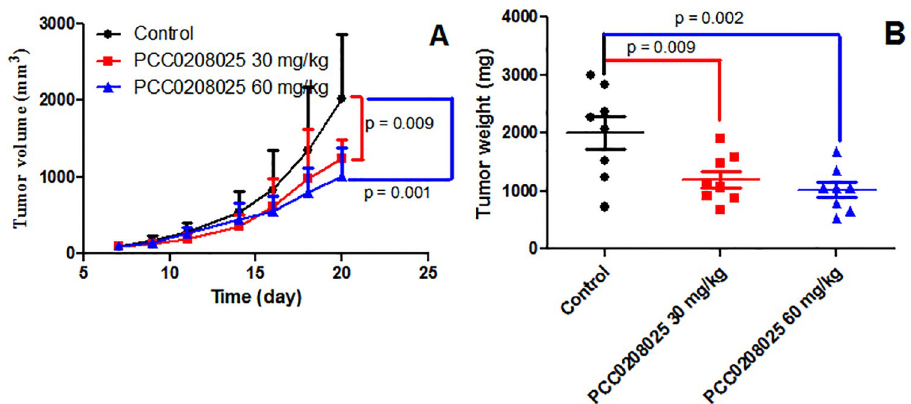
Fig 4. Effects of PCC0208025 on tumor growth in B16-F10 tumor isograft model. B16-F10 tumors were established by injecting 1 × 10 5 cells mixed with matrigel into the dorsal area of male mice. On 2 rd day, the mice bearing tumors were randomly divided into three groups. Mice were administrated by oral gavage with PCC0208025 at 30 mg/kg or 60 mg/kg with a volume of 0.1 ml/10 g, twice daily. Control mice were given the same volume of saline. On days 7, 9, 11, 14, 16, 18 and 20, tumor dimensions were measured. On day 20, all the mice were decapitated between 9:00 a.m. and 11:00 a.m.. The tumors were obtained. And the inhibition rate (IR) of tumor growth was calculated. (A) PCC0208025 had tumor inhibition effects in tumor volume compared with control group ( P < 0.05, n = 8) on day 20. (B) PCC0208025 had significant tumor inhibition effects in tumor weight compared with control group ( P < 0.05, n = 8). The results were presented as mean ± SD. � P < 0.05 compared with control